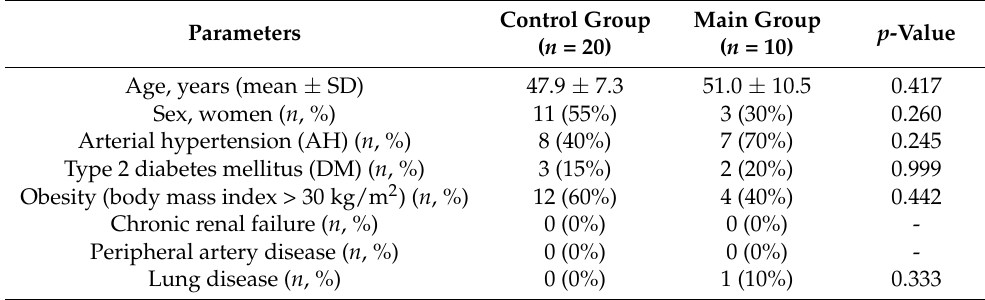
Table 1. The main demographic data and comorbid conditions in the studied groups.